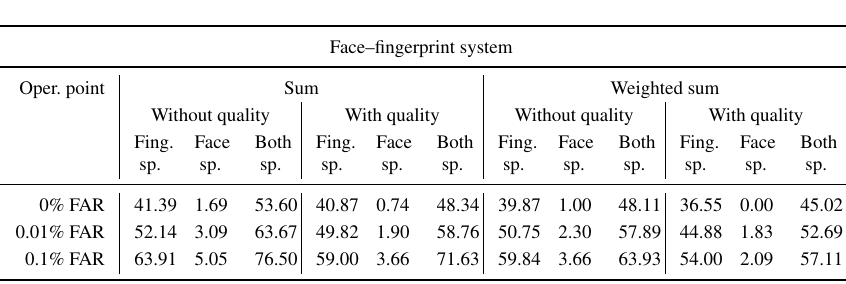
Table 5. FAR (%) of the face–fingerprint system with and without biometric sample quality, using sum, and weighted sum rules, when either the fingerprint, the face or both the fingerprint and face are spoofed, at three operating points.